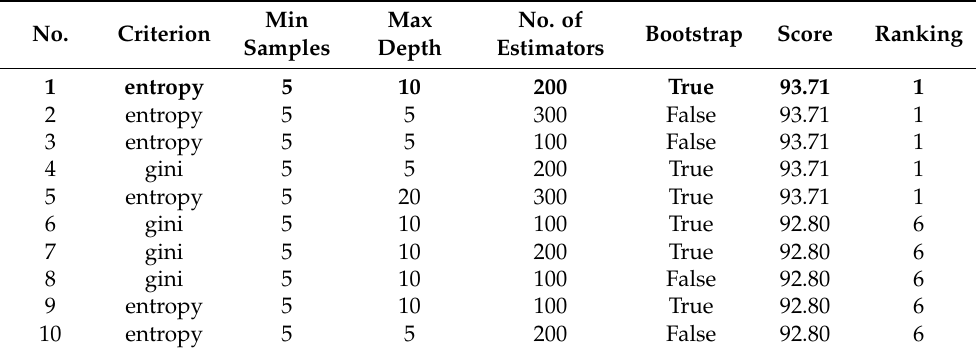
Table 5. Random Forest hyperparameter-tuning